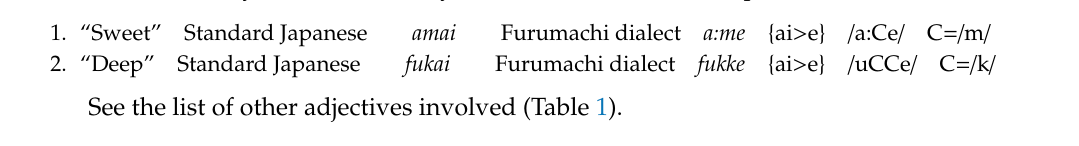
Table 1. List of adjectives used in Furumachi, Niigata